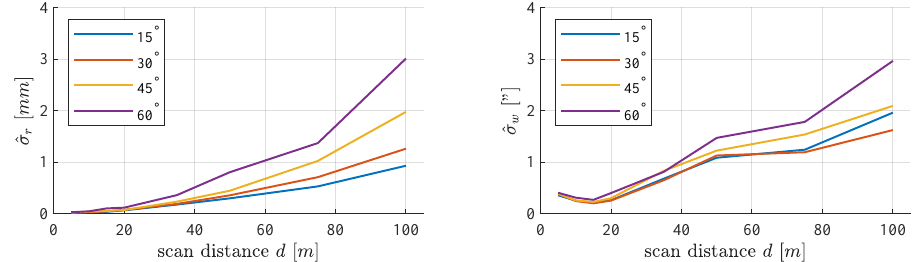
Figure 11. Standard deviations in distance direction ˆ σ r and angular direction ˆ σ w for different incidence angles, targets scanned with Leica ScanStation P20 and a resolution of 0.8 mm at 10 m (calculated from data of targets t 1– t